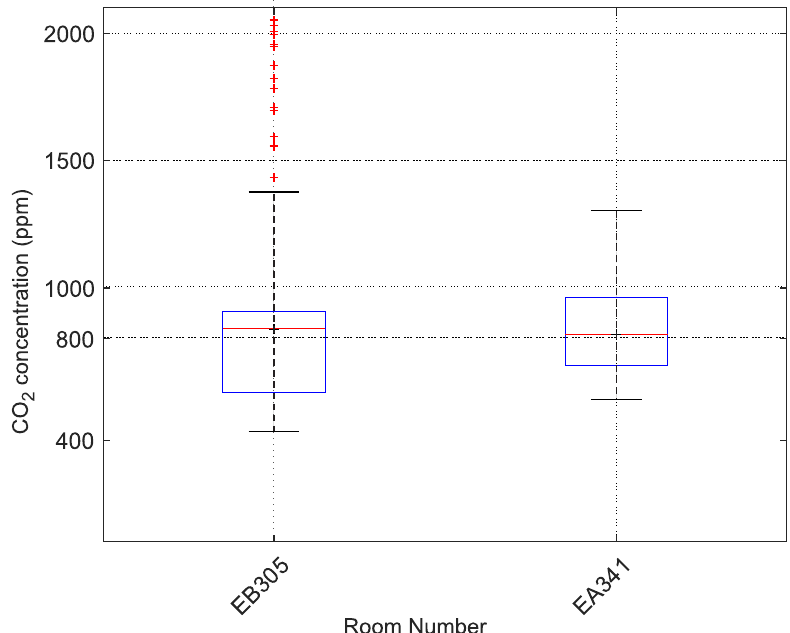
Figure 8. Boxplot for room numbers EA341 and EB305 on 18 February 2019, VŠB-TUO.